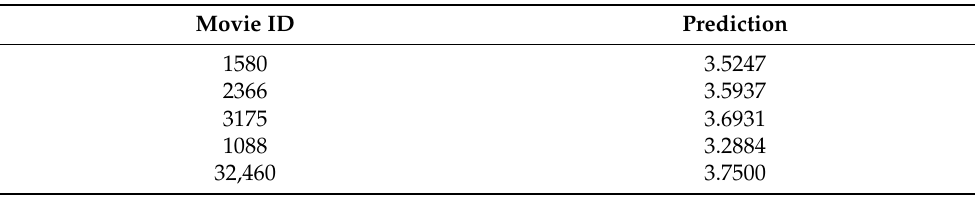
Table 3. Movies predictions for Movie IDs.